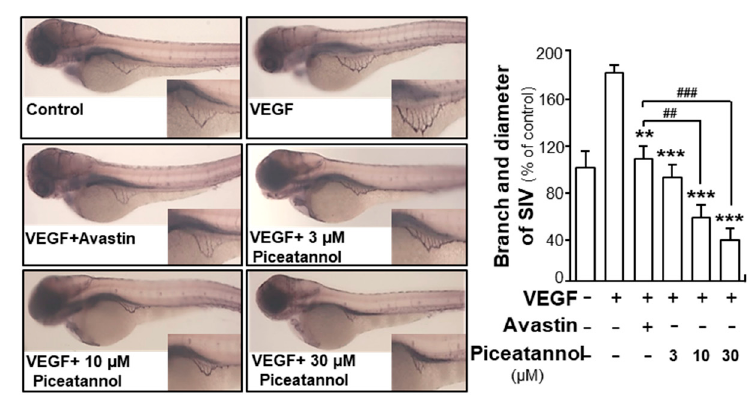
Figure 3. Piceatannol suppresses angiogenesis in vivo. Healthy zebrafish embryos were selected and divided into groups randomly. On 1st day of development, embryos were incubated with phenylthiourea (PTU) water containing VEGF (10 ng/mL) in the presence or absence of piceatannol at different concentrations. Avastin (200 µg/mL) served as a positive control. For the negative control, immunoglobulin prepared at the same concentration as Avastin was used here. Drug treatment lasted for 48 h and on the 3rd day development of zebrafish embryos, fish embryo staining was performed. Pictures demonstrating the subintestinal vessels and formation of blood vessels were captured. The branches and area of subintestinal vessels in different groups of drugs at different concentrations were analyzed and quantified by applying Image J software. Data expressed as mean ± SEM of the percentage of control group, where n = 3; p < 0.01 (**); p < 0.001 (***) vs. VEGF-treated group. p < 0.01 (##); p < 0.001 (###) vs. Avastin-treated group, as shown. Bar = 40 µm.